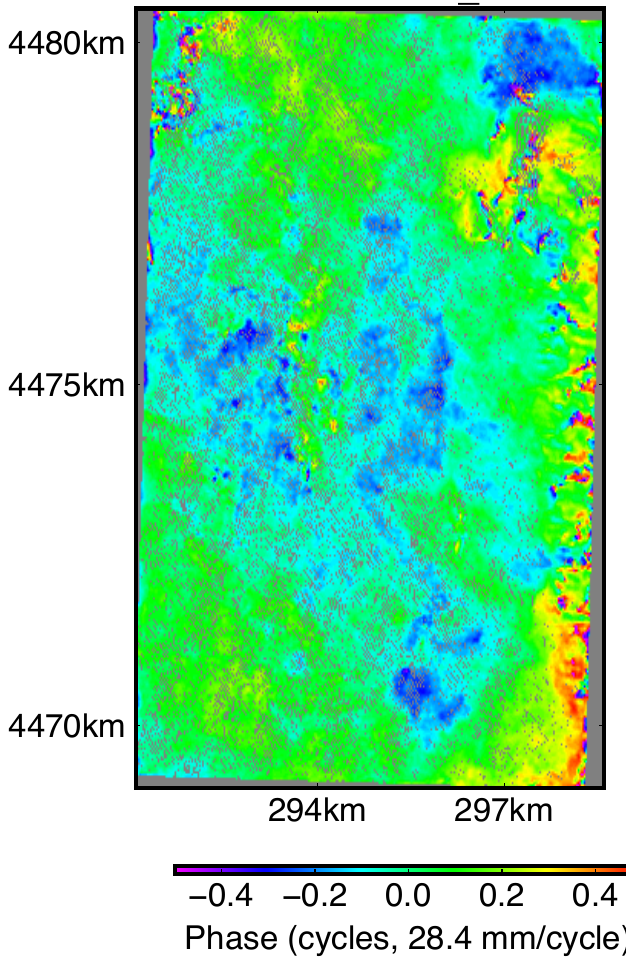
Figure A2. Deformation field at San Emidio in terms of wrapped range change in cycles from an ERS track 27 pair spanning 30th July 1997 to 8th October 1997. One cycle of wrapped phase corresponds to a range change of approximately 28 mm. Orbital baseline b ⊥ = 445.7 m and temporal baseline ∆ t = 70 days. Coordinates are easting and northing kilometers in UTM projection zone 11N, WGS84